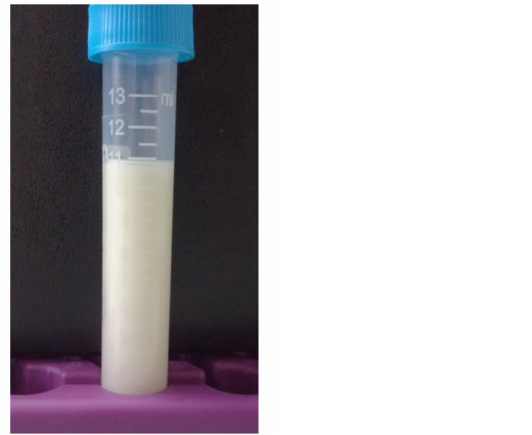
Figure 2. Optical photo of oil in water Pickering emulsion with 4 mass% of Kao in the presence of Laponite ® as thickener agent.